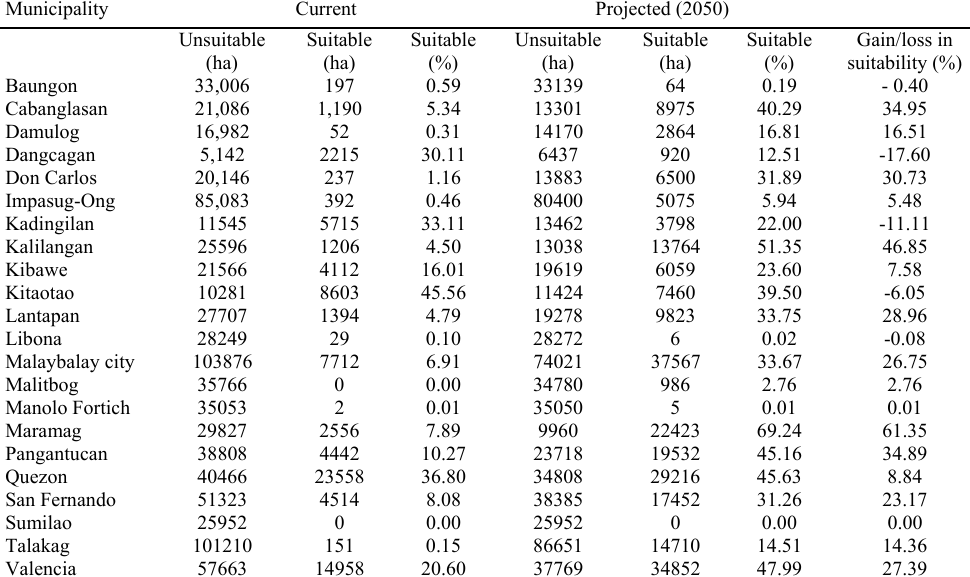
Table 4: Areal and percentile distribution of suitability per municipality